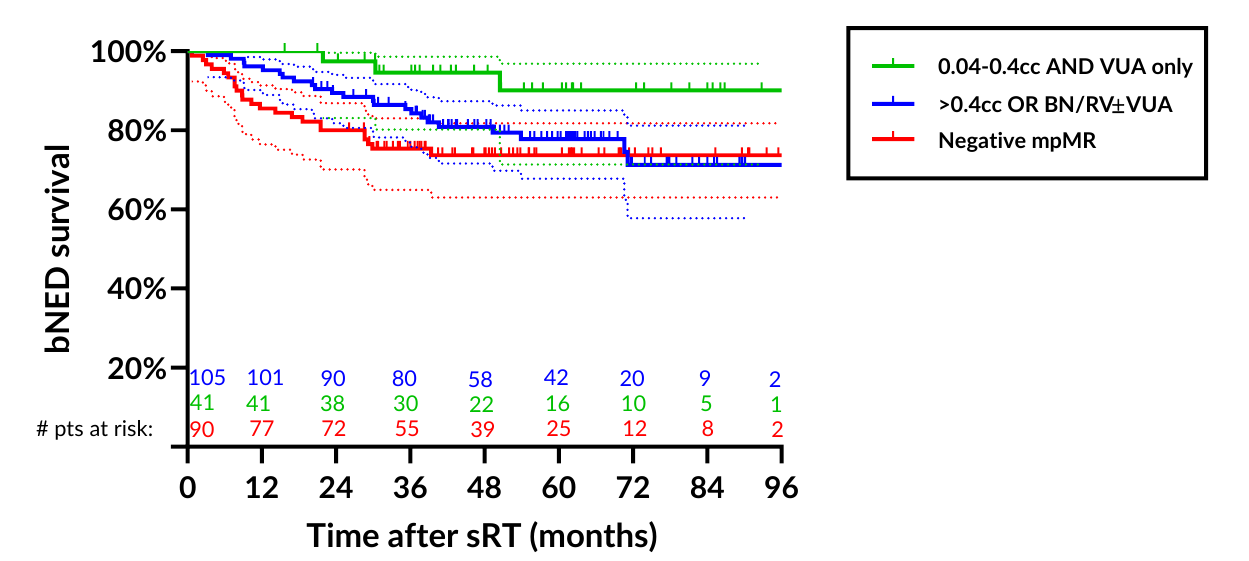
Figure 3. Biochemical control rates after salvage radiotherapy stratified by the location of the lesion (none, VUA-only, BN/RV ± VUA) and by the volume of the lesion at DCE-MRI using as a cutoff a median value of 0.4 cc. For patients with VUA-only disease up to 0.4 cc, the bNED rate at 4 yrs was 94.6% (95%CI: 80.2–98.6%) (green line), for patients with >0.4 cc or other detectable lesions (BN/RV ± VUA), the 4 yr bNED rate was 80.9% (95%CI: 71.6–87.4%) (blue line) and 73.7% (95%CI: 63.1–81.8%) (red line) for patients with negative mpMRI. Abbreviations: bNED: biochemical no evidence of disease; sRT: salvage